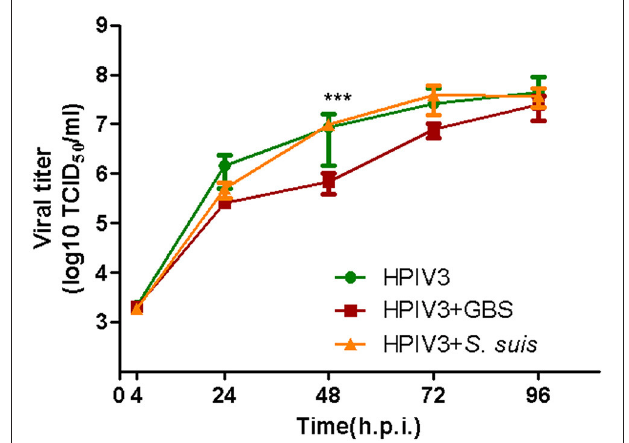
FIGURE 4 | Effects of co-infection by streptococci on the replication kinetics of HPIV in HEp-2 cells. HEp − 2 cells were infected by HPIV (MOI = 0.5), followed by 2h incubation with GBS (red line) or S. suis (orange line). Supernatants were harvested at different time point post-virus infection and titrated by determining the TCID 50 on HEp-2 cells. Results represent the mean value of virus titers ± SEM pooled from three independent experiments with duplicated samples. Asterisks indicate significant differences at 48h.p.i. between cells infected by virus alone (green lines) and cells co-infected by HPIV and GBS (red line). Statistical analysis was performed with one-way ANOVA, *** P < 0.001